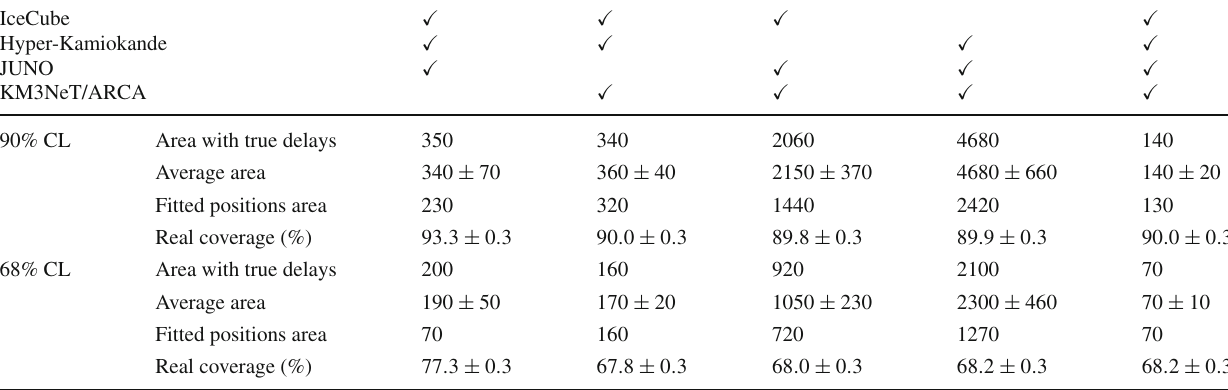
Table 5 Error box areas of the CCSN localisation in deg 2 at 90 and 68% confidence levels for the considered detector combinations com- puted inthree different ways: (a) using the true delays; (b) from 100,000 randomized time delay realisations; (c) as the area covering 90 and 68% of the fitted position distribution. The real coverage is also provided and